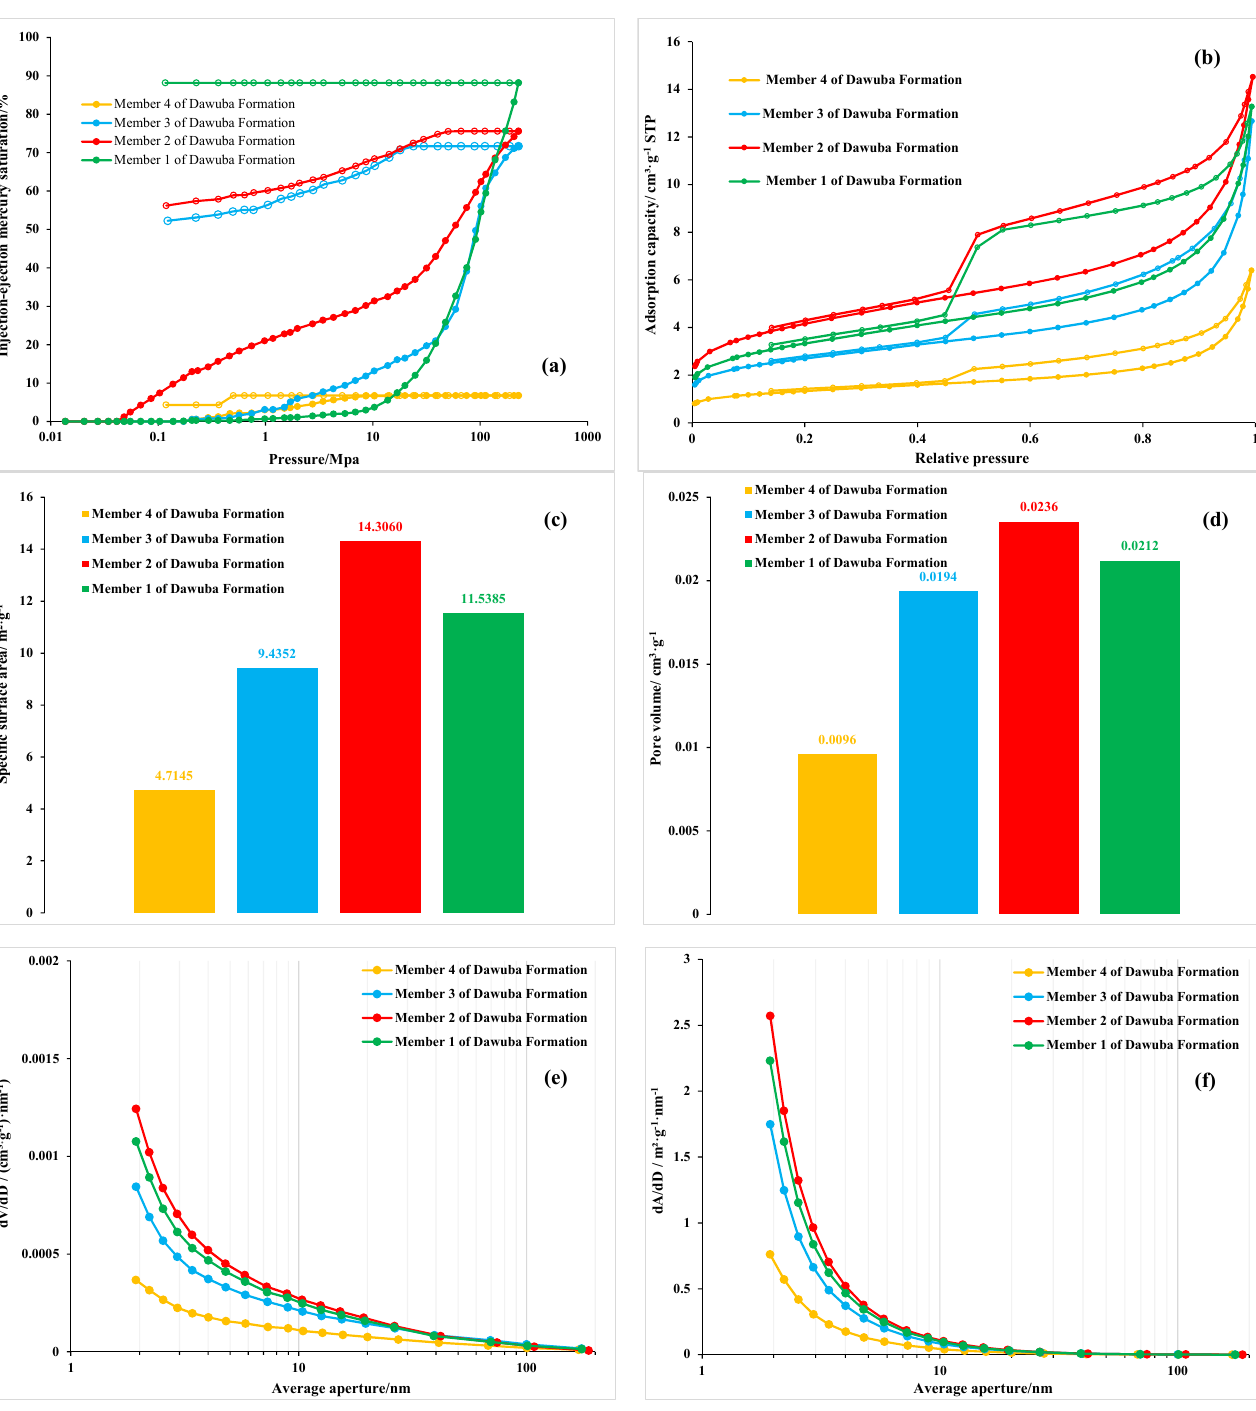
Figure 5. Pore distribution characteristics at different scales of the Dawuba Formation shale in Well QSD-1. ( a ) The mercury injection–withdrawal curve of each member of the Dawuba Formation shale; ( b ) nitrogen adsorption–desorption curve of shale in each member of the Dawuba Formation; ( c ) Based on the distribution of specific surface area of shale in each member of Dawuba Formation by N 2 adsorption; ( d ) shale pore volume distribution based on N 2 adsorption; ( e ) shale pore volume change rate distribution based on N 2 adsorption; ( f ) specific surface area distribution of shale in each member of the Dawuba Formation based on N 2 adsorption.